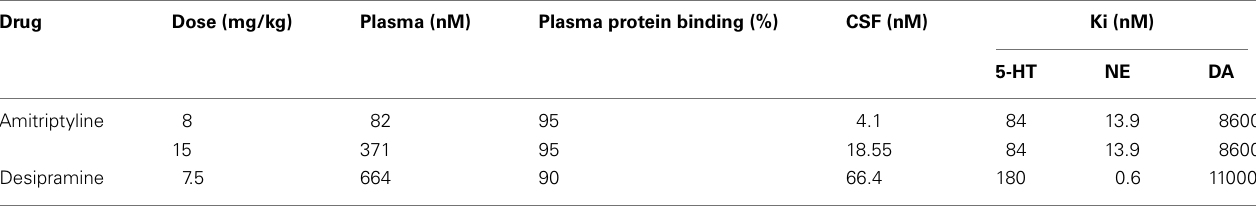
Table reviewing available literature of studies using: chronic subcutaneous administration, adult rats, drugs of interest at comparable doses to those used in this study, and reported plasma concentrations [8mg/kg amitriptyline (Brodin et al., 1994), 15mg/kg amitriptyline (Benmansour et al., 1999), and 7.5mg/kg desipramine (Gould et al., 2006)]. Reported cerebrospinal fluid (CSF) concentrations were calculated by multiplying reported drug plasma concentrations and reported plasma protein binding percentages [amitriptyline (Schulz et al., 1985) and desipramine (Sallee and Pollock, 1990)]. Reported Ki values for serotonin (5-HT), norepinephrine (NE), and dopamine (DA) transport proteins are for rat synaptosomes (Bolden-Watson and Richelson, 1993).